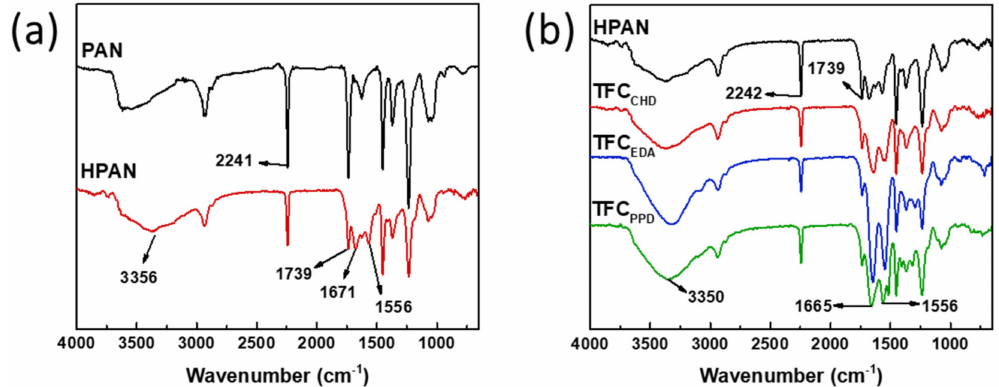
Figure 2. ( a ) ATR-FTIR spectra of the PAN, HPAN, and ( b ) TFC